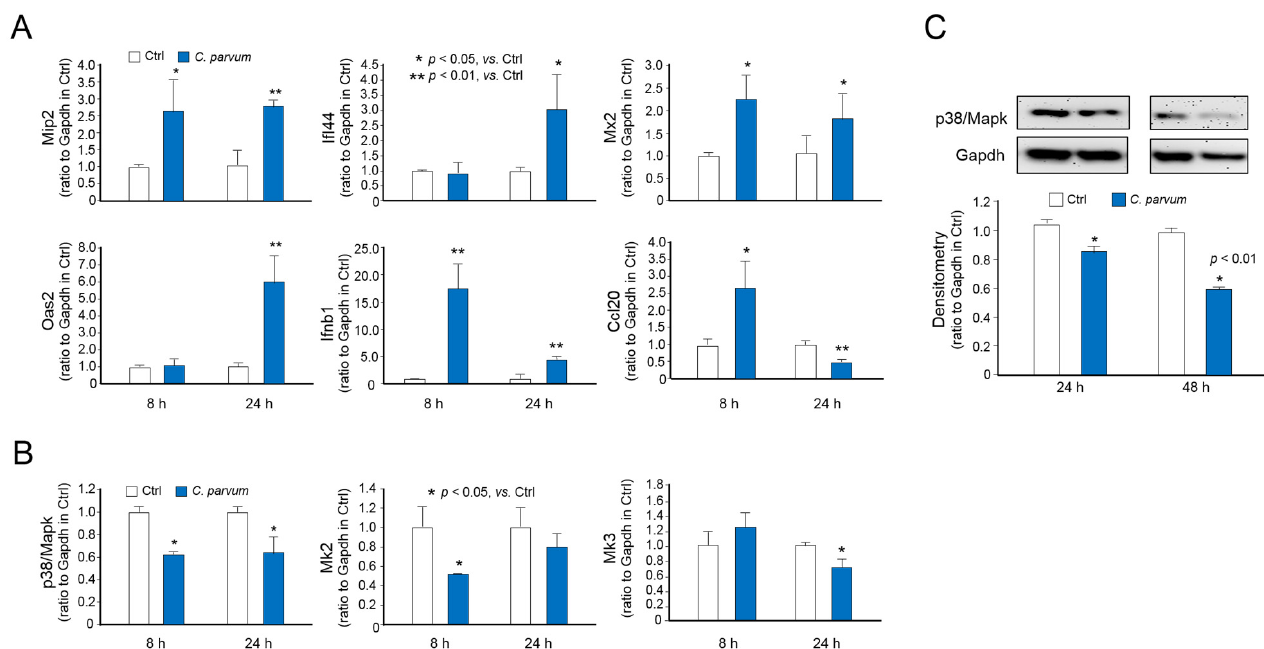
Figure 3. Downregulation of p38 / Mapk , Mk2 and Mk3 genes in intestinal epithelial cells following C. parvum infection. ( A ) RNA levels of a panel of inflammatory genes in IEC4.1 cells following C. parvum infection. Cells were exposed to C. parvum infection for 8 and 24 h. RNA levels of these genes were measured by using real-time quantitative PCR. ( B ) RNA levels of p38 / Mapk , Mk2 and Mk3 genes in IEC4.1 cells following C. parvum infection. Cells were exposed to C. parvum infection for 8 and 24 h. RNA levels of p38 / Mapk , Mk2 and Mk3 genes were measured. ( C ) Protein level of p38/Mapk in IEC4.1 cells following C. parvum infection. Cells were exposed to C. parvum infection for 24 h and 48 h. Protein level of p38/Mapk was assessed by using Western blot. Gapdh was also blotted for control. Data represent three independent experiments.